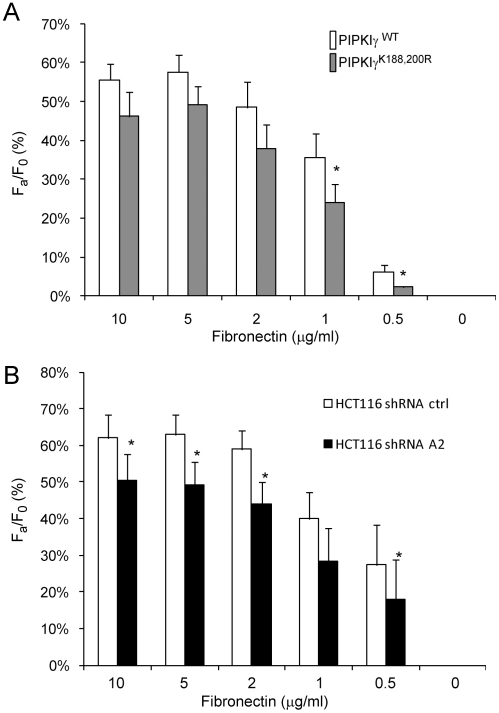
Either expression of PIPKIγK188,200R or depletion of PIPKIγ impaired the adhesion strength of HCT116 cells on fibronectin.(A) Expression of PIPKIγK188,200R inhibited HCT116 cells adhering to low concentrations of fibronectin. The cells stably expressing PIPKIγ or PIPKIγK188,200R were incubated with Calcein-AM and plated on a 96-well plate coated with fibronectin for centrifugation assays. (B) Depletion of PIPKIγ inhibited HCT116 cells adhering to fibronectin. The cells that stably express control and PIPKIγ shRNA were incubated with Calcein-AM and plated on a 96-well plate coated with fibronectin for centrifugation assays. Fa/F0 =  (fluorescence after centrifugation)÷(fluorescence before centrifugation).